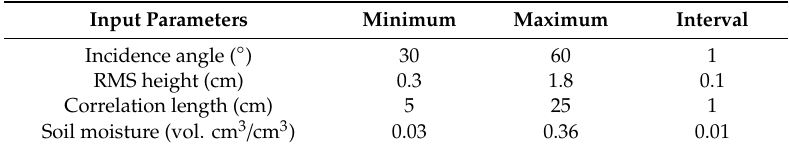
Table 2. Values of the input parameters to the AIEM